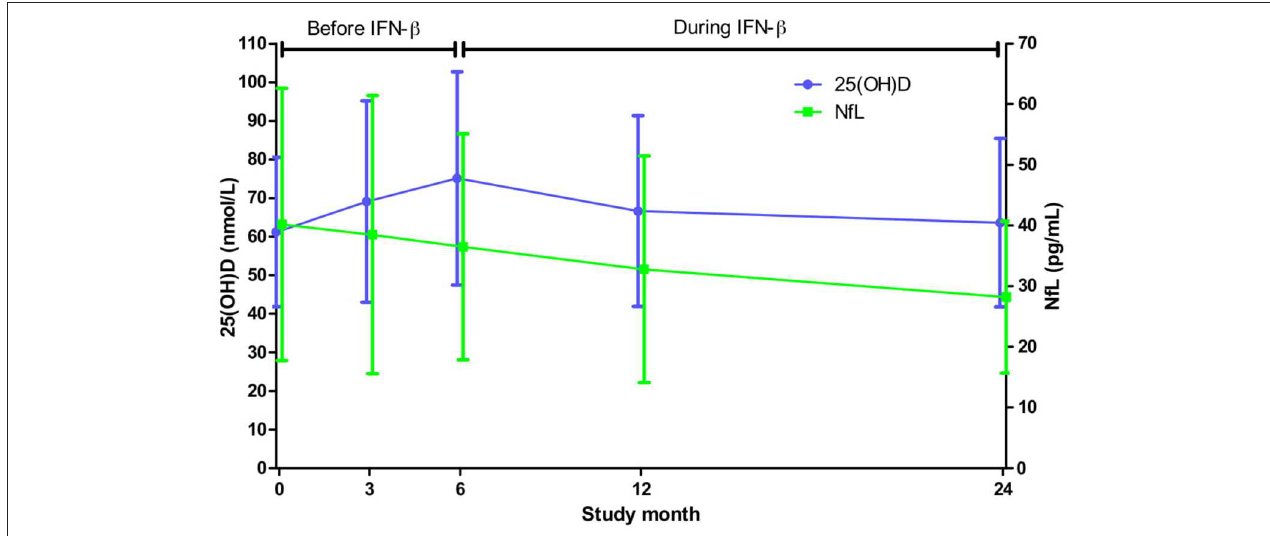
FIGURE 1 | Mean (SD) serum levels of 25(OH)D and NfL throughout the study. Based on all available 25(OH)D and NfL measurements from a minimum of 85 and 79 patients, respectively, at each point of time.